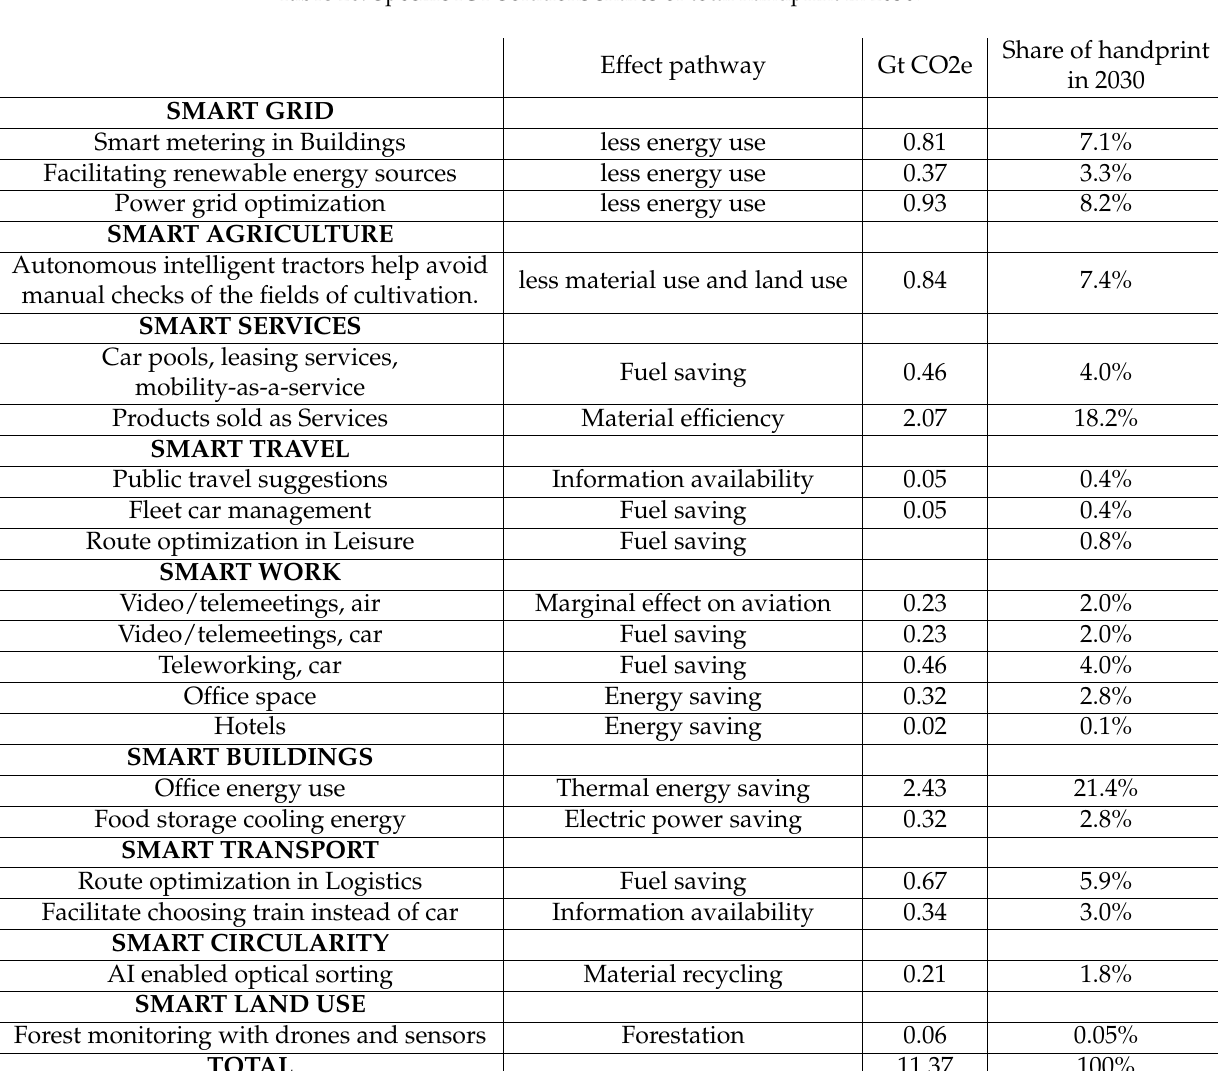
Table 20. Specific ICT Solutions shares of total handprint in